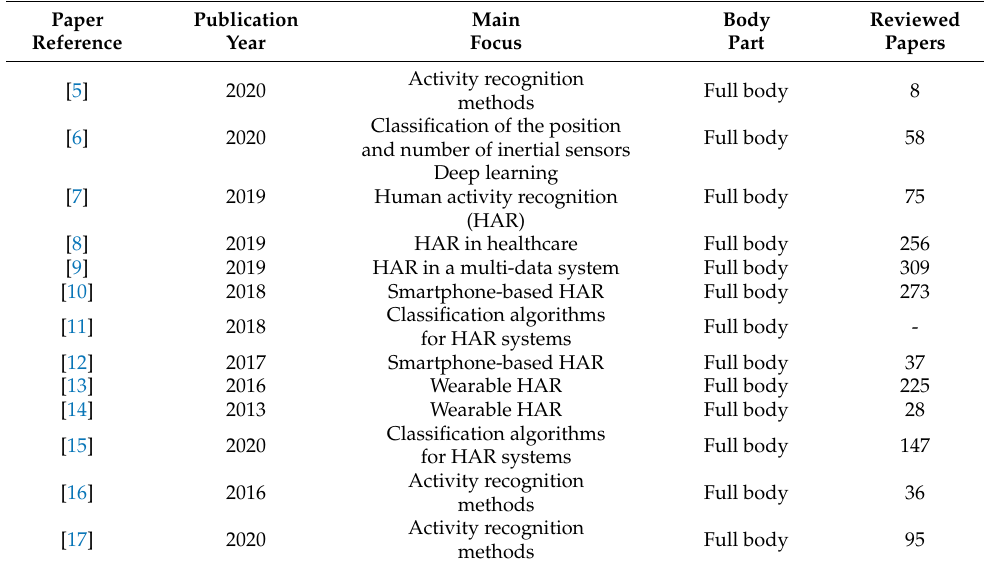
Table 1. Existing human activity recognition